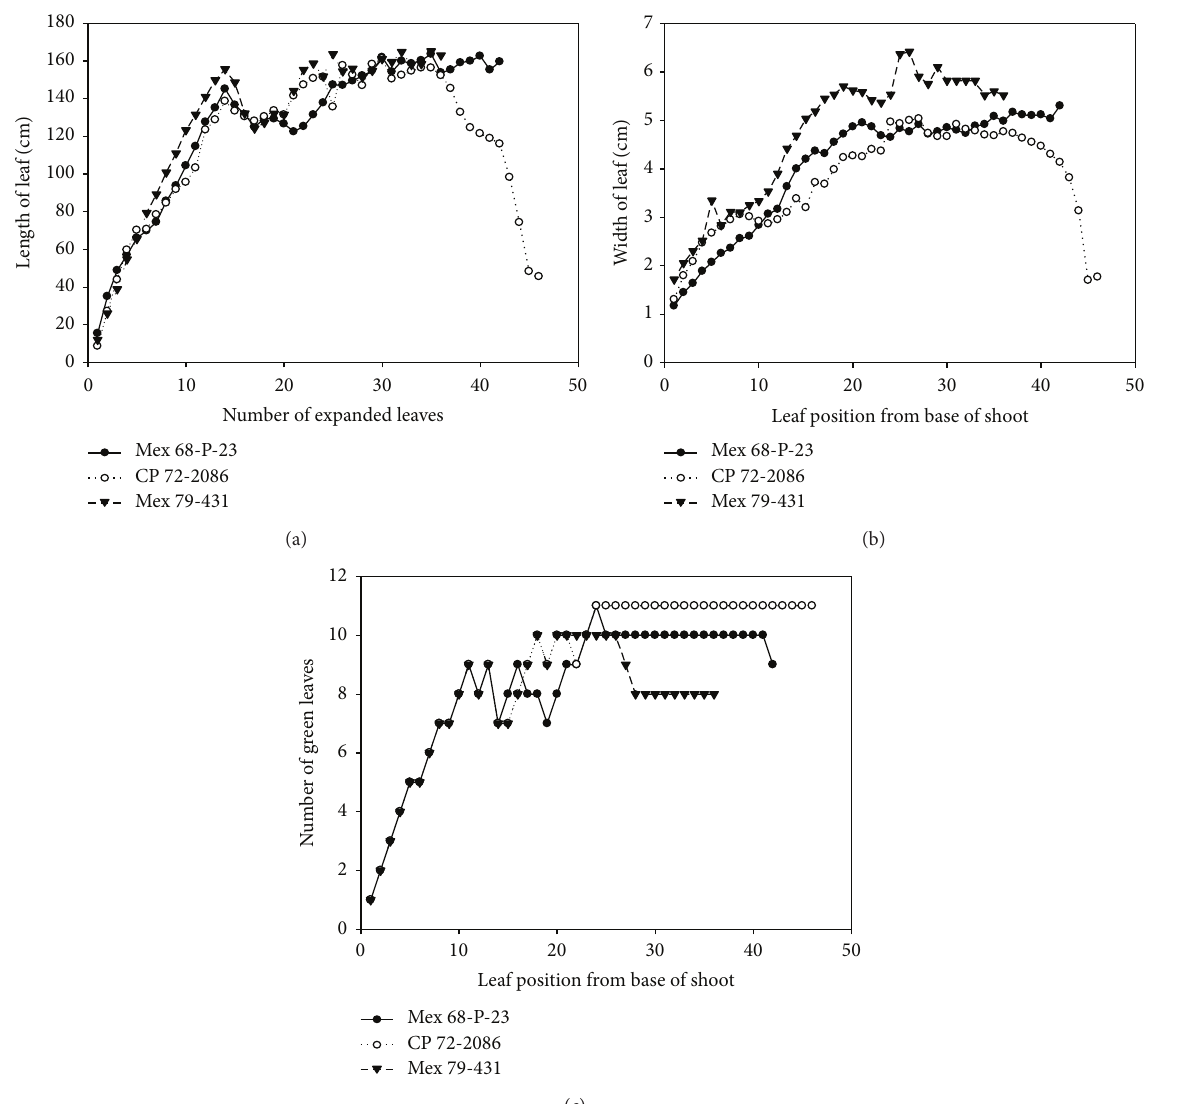
Figure 2: Length (a), width (b) of each leaf lamina, and total number of leaves (c) for the three sugarcane cultivars under high temperature rainfed conditions in Northeastern